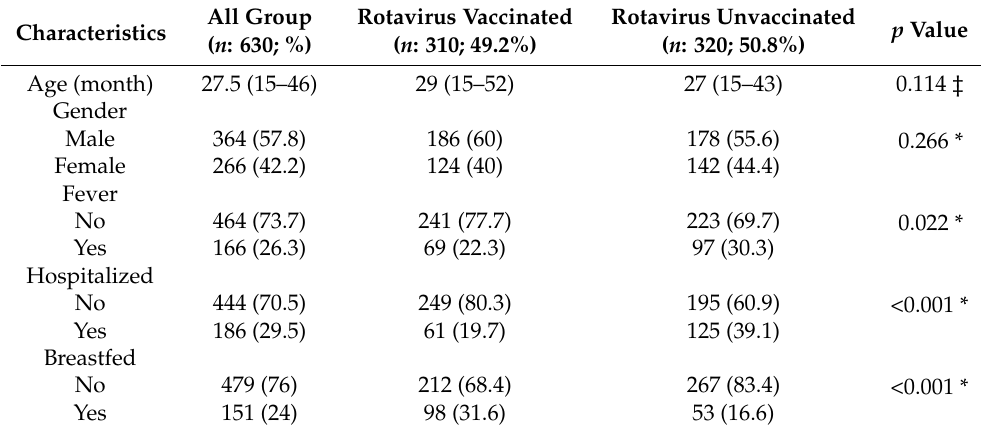
Table 1. Demographic and clinical characteristics of children by rotavirus vaccination status. All Group Rotavirus Characteristics